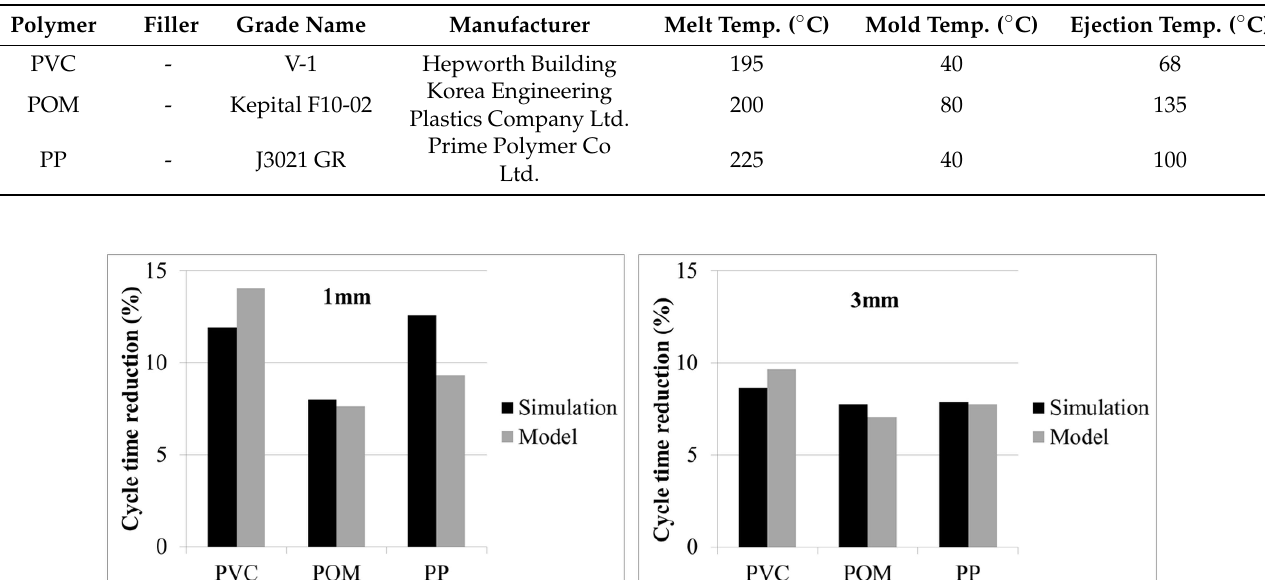
Figure 9. Validation of correlation model for three randomly chosen polymers for two wall thicknesses (left: 1 mm, right: 3 mm).